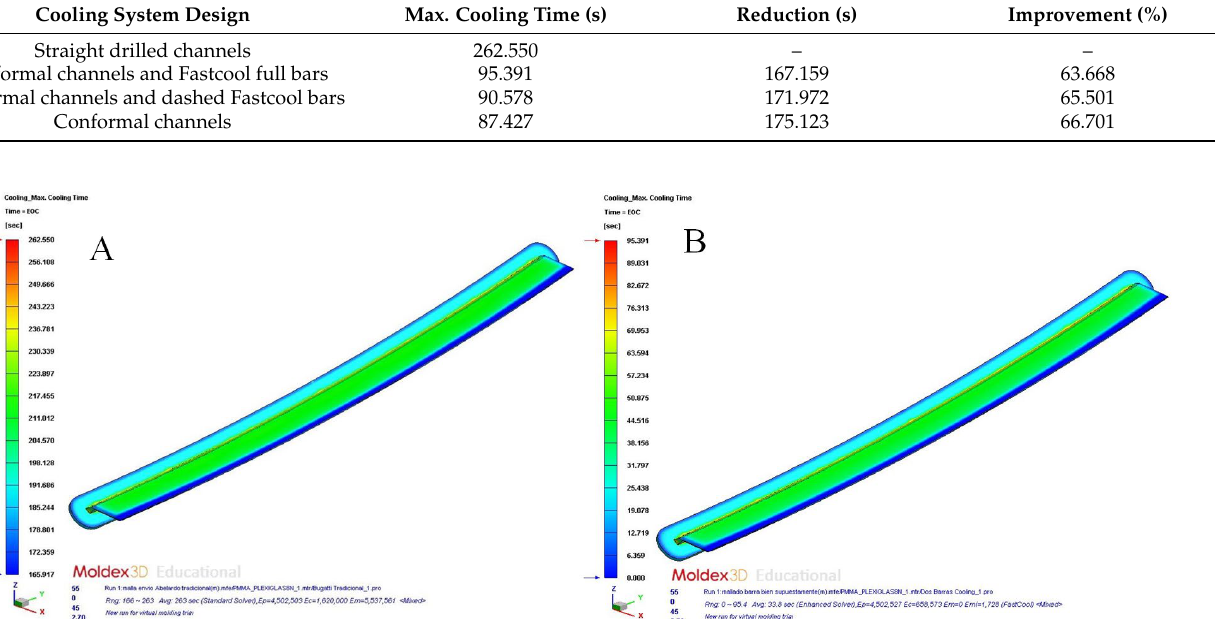
Figure 14. Maximum cooling time (s); conformal channels—dashed Fastcool bars ( A ), conformal channels ( B ). From the resulting parameter “Max. Cooling Time”, which was obtained for the de- sign of a traditional cooling system based on straight drilled channels, it was established that the analytical model used to determine the cooling time of the plastic part under study (see Table 6) was valid. According to the analytical model, the cooling time obtained was equal to 271.50 s, while the result obtained in the numerical simulations was equal to